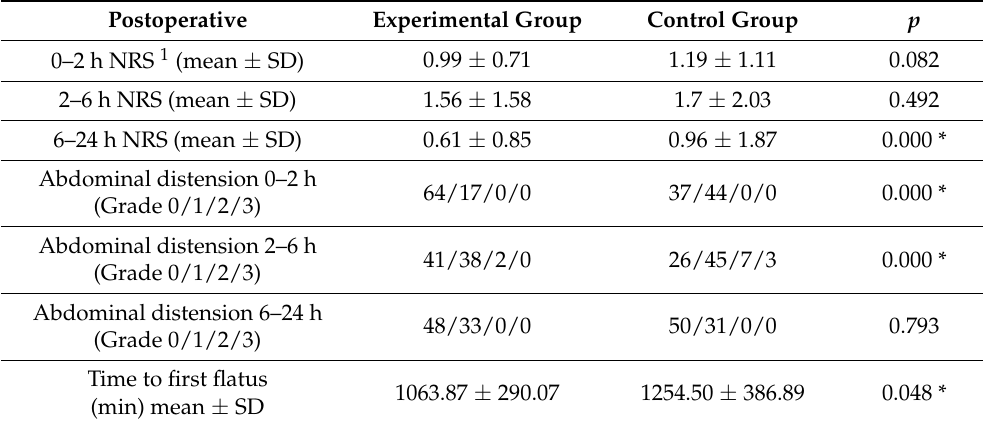
Table 3. Comparison of postoperative pain, abdominal distension, and time to first flatus. Postoperative Experimental Group Control